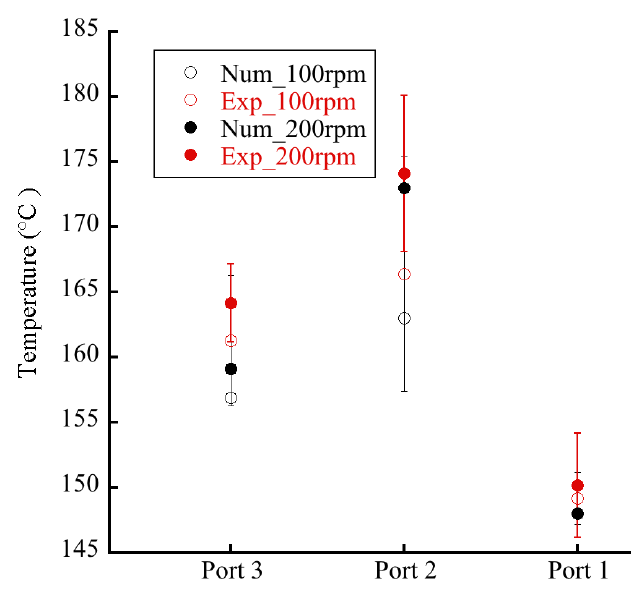
Figure 8. Measured and calculated temperature distributions in an octa-screw extruder.